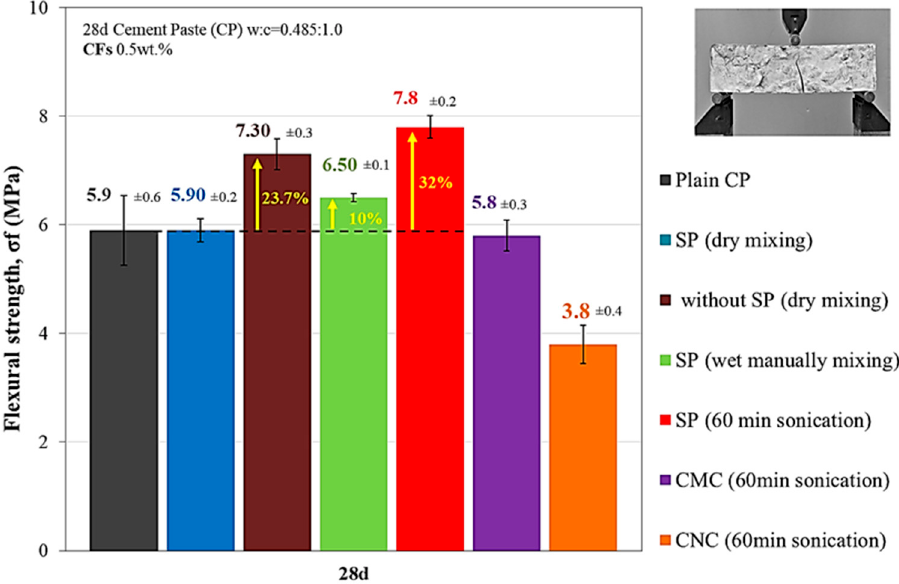
Figure 6. Flexural strength of 28-day plain cement pastes and CFs reinforced cementitious compo- sites.